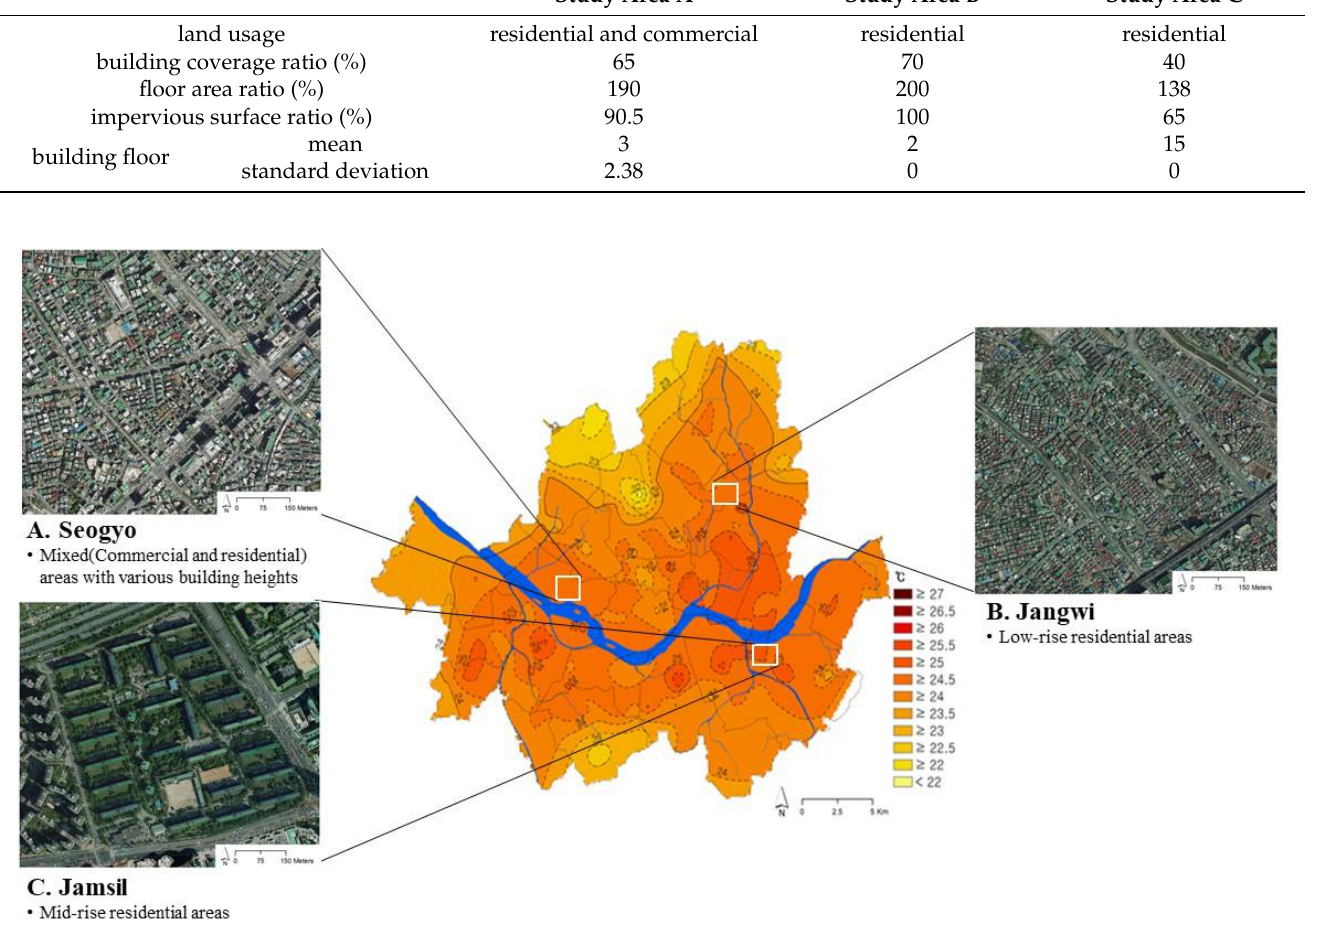
Figure 5. The study areas of case study 2. (Source: Satellite imagery, http://maps.kakao.com, accessed date: 20 August The study areas of case study